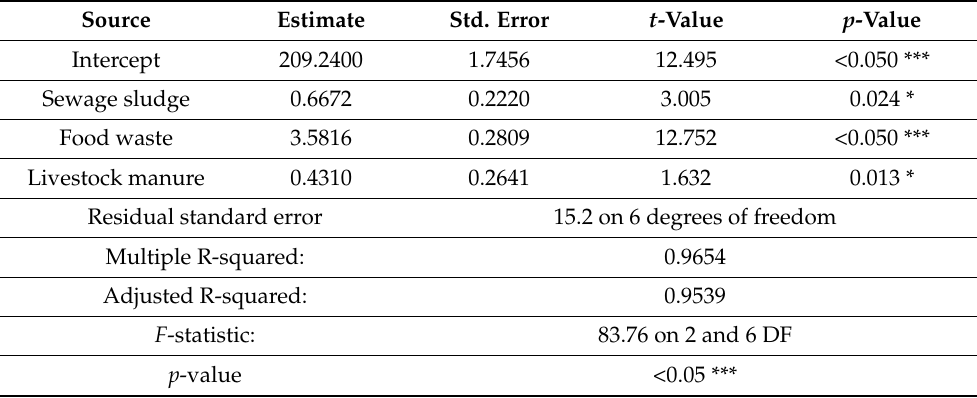
Table 8. Cumulative methane production from multiple